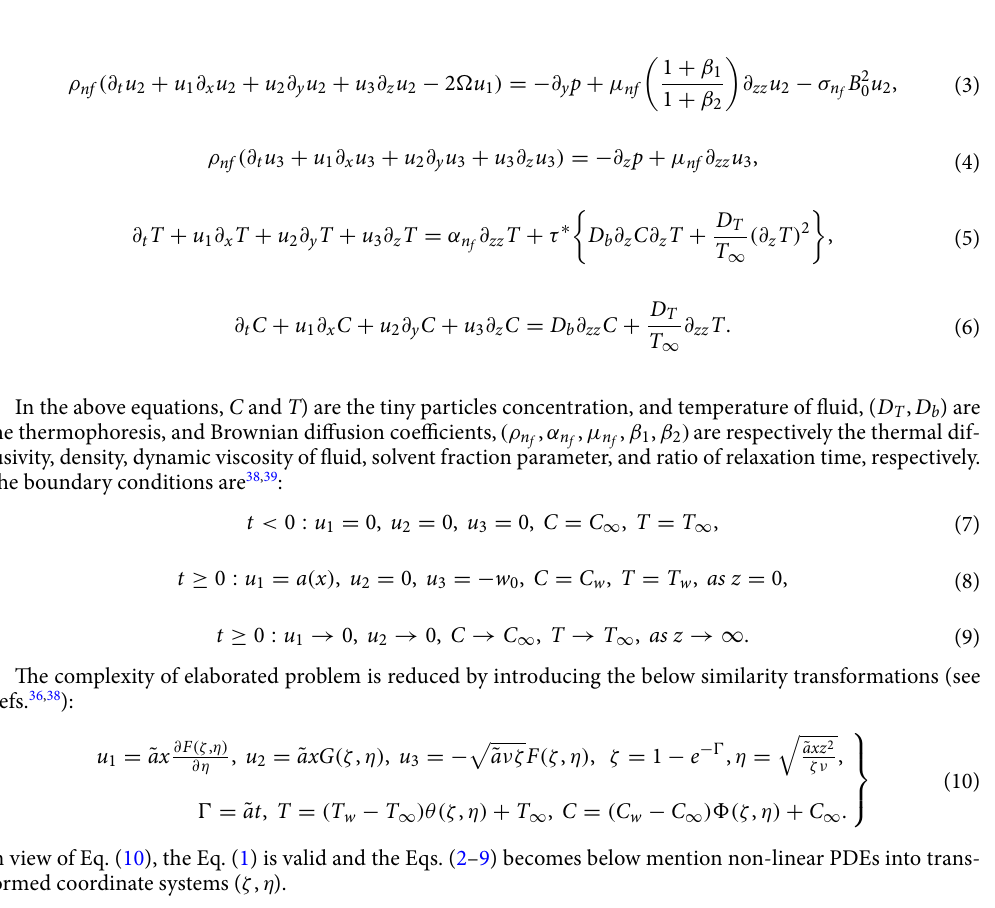
Figure 1. Physical configuration and coordinate